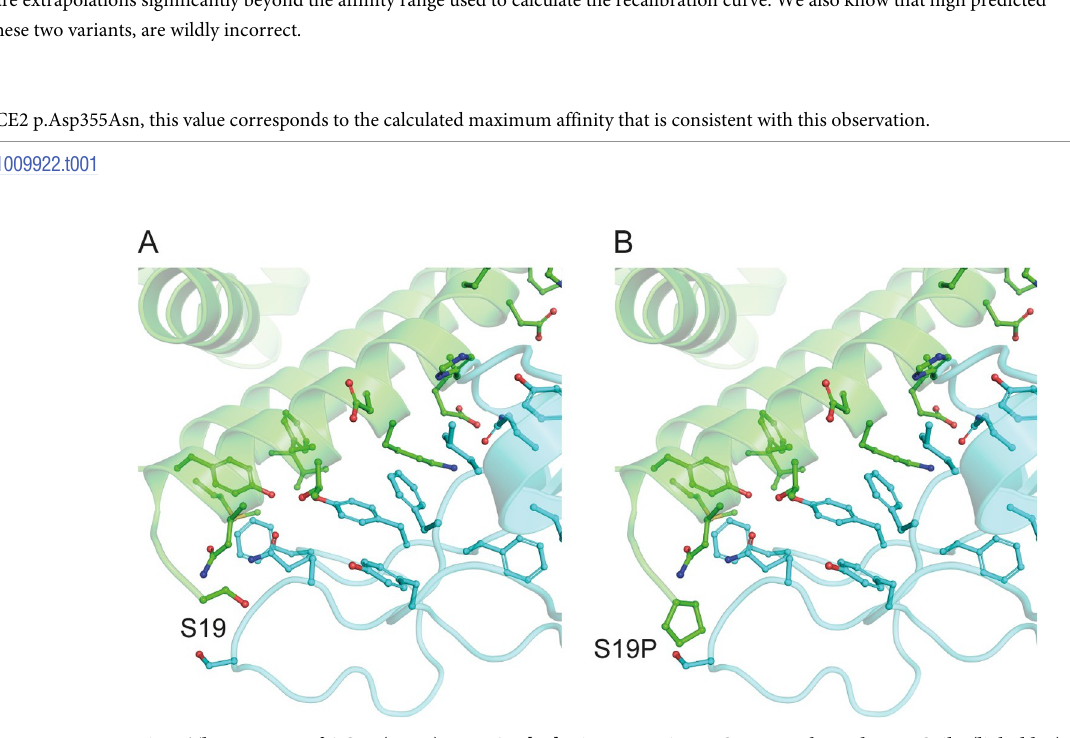
Fig 2. The structure of ACE2 (green) gnomAD [24] missense variant p.Ser19Pro that enhances Spike (light blue) binding affinity. A. The environment of ACE2 Ser19 from PDB ID: 6vw1 [11]. B. Model of ACE2 p.Ser19Pro in complex with Spike. The mutant structure was modelled onto 6vw1 with mCSM-PPI [13]. Figure created with PyMol